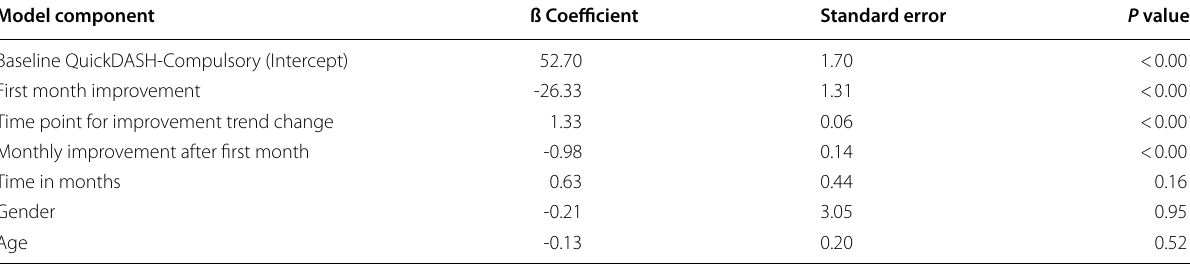
Table 3 Hierarchical Lineal Modeling for QuickDASH-Compulsory score Model